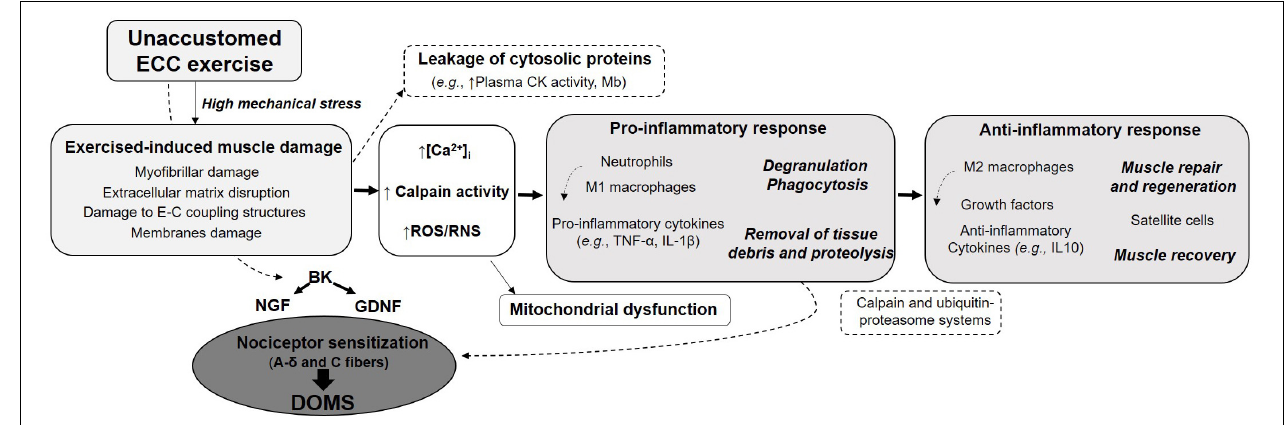
FIGURE 1 | Summary of the main specific features of eccentric contraction, its multi-target beneficial effects and potential risks associated with unaccustomed and/or maximal eccentric exercise.